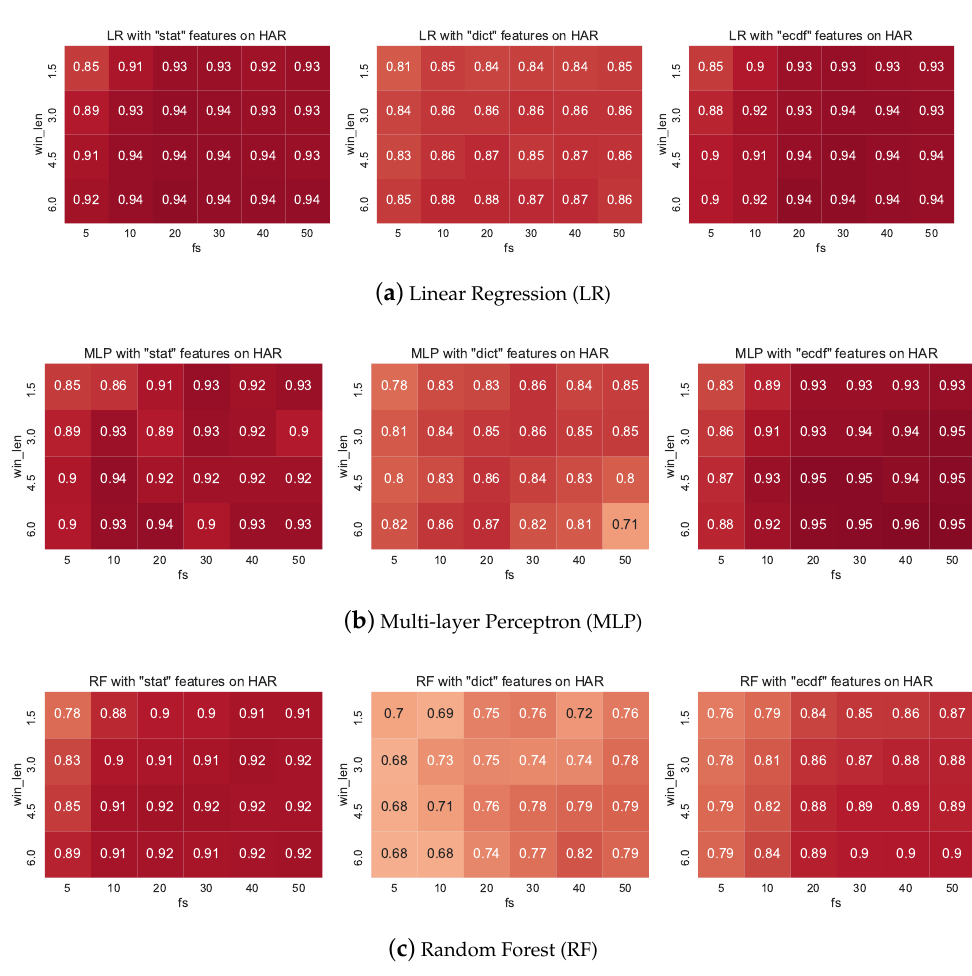
Figure A1. Classification performance on the HAR dataset with all iid feature